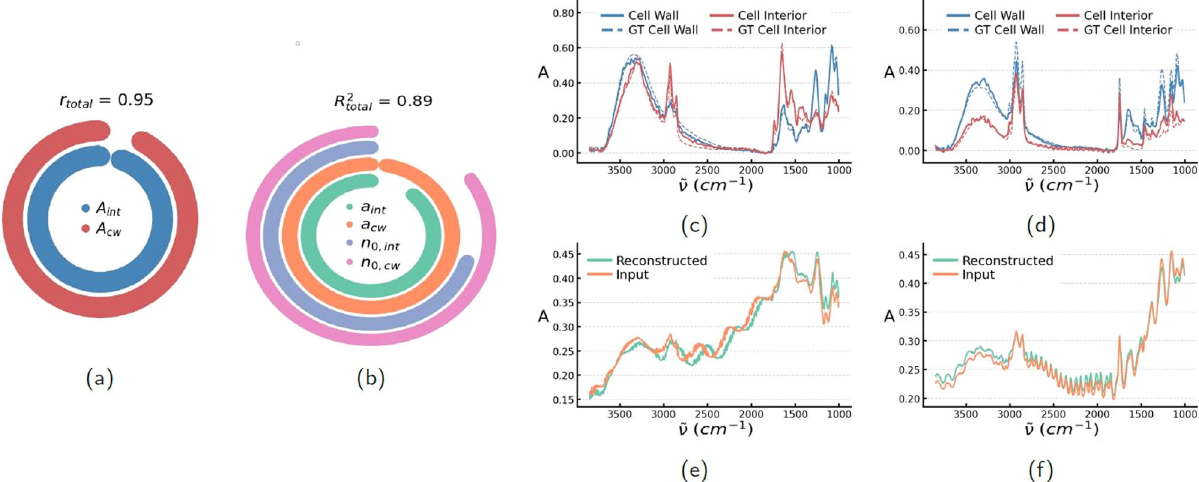
Fig. 2 The ISP-solver applied to simulated spectral data. a The performance metrics for the prediction of molecular absorption, given as the Pearson correlation coef fi cient r . b The prediction of optical parameters quanti fi ed by the coef fi cient of determination R 2 . For both metrics the circle bar starts at 0 and a fully drawn circle implies the metric being 1. c , d The molecular absorption of the cell interior and the cell wall of the concentrically spherical sample. The dashed lines represent the ground truth and the fully drawn model ’ s predictions. e , f The simulated scatter-distorted spectra and the reconstructed spectra from the predicted complex refractive index functions. All metrics and spectra in a – f are coming from the continuous simulated data set which was also used for training the model. The statistical measures in a , b are estimated on a population of n = 10,000 simulated